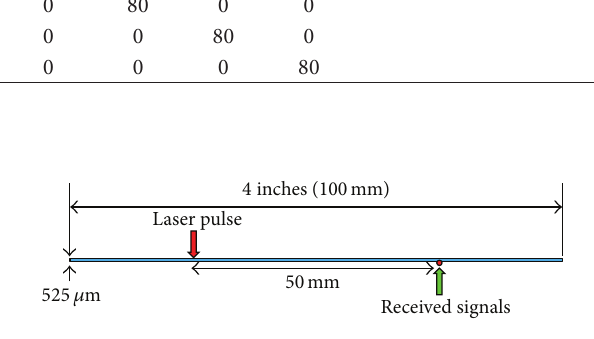
Figure 3: Geometrical dimensions of simulation model.